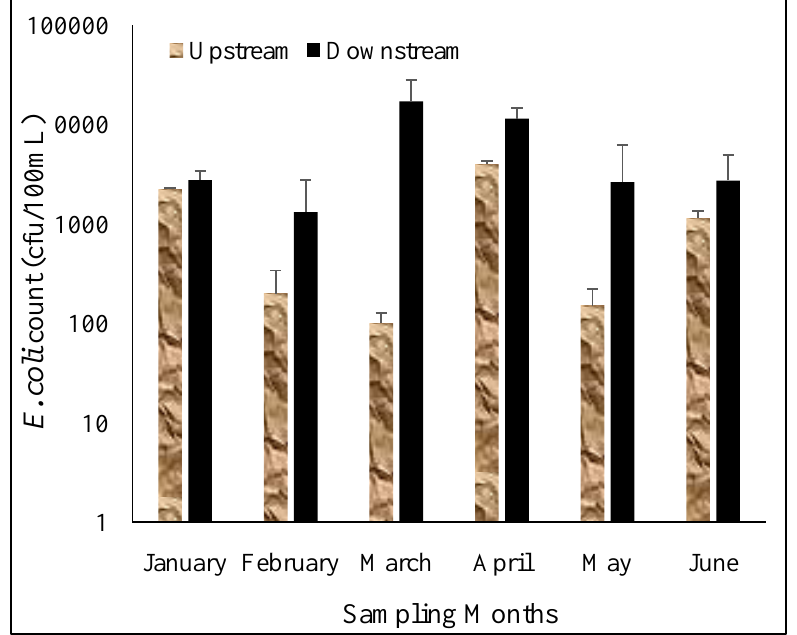
Figure 4. E. coli count in the upstream and downstream of Mvudi